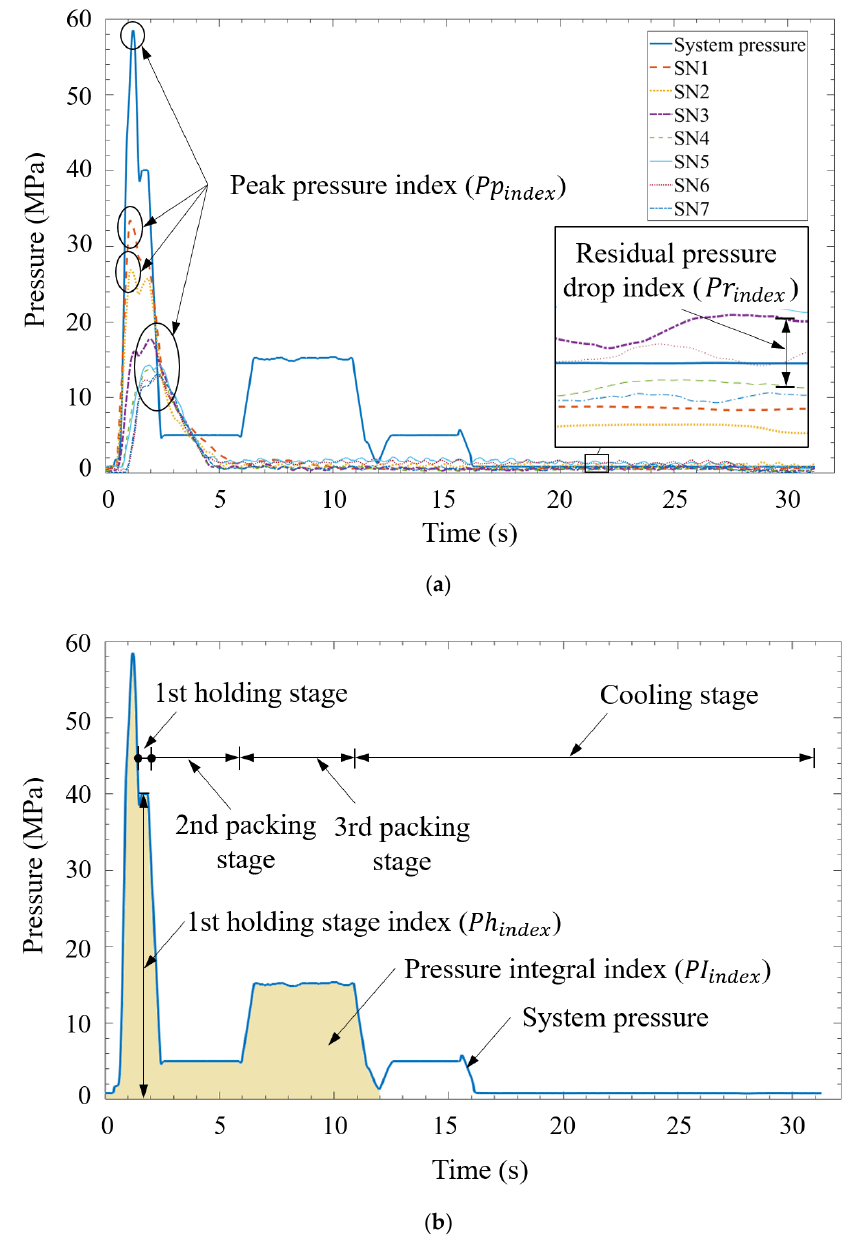
Figure 12. Quality indices: ( a ) peak pressure index and residual pressure drop index and ( b ) pressure integral index and first-stage holding pressure index.